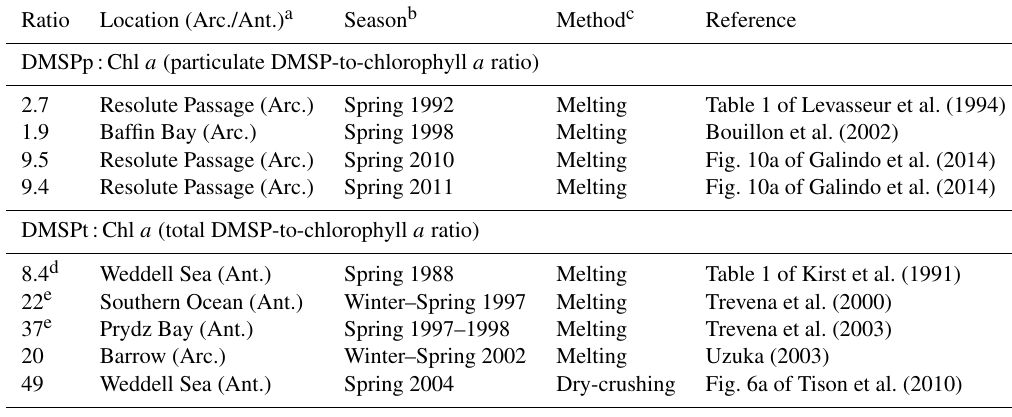
a Arc.: Arctic; Ant.: Antarctica b Winter: January–March (July–September) for Northern (Southern) Hemisphere; Spring: April–June (October–December) for Northern (Southern) Hemisphere. c Either melting or dry-crushing as described by Stefels et al. (2012). d Average of brown ice and ice core samples.